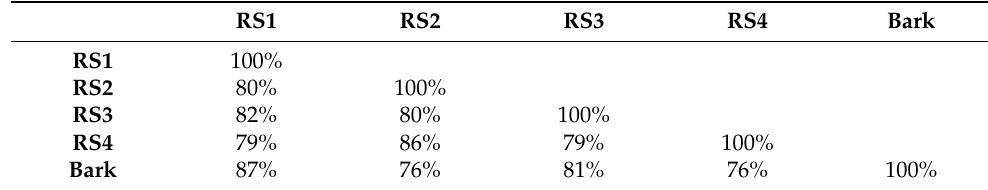
Table 4. Similarity matrix based on the CDDP analysis of the five tomato genotypes.